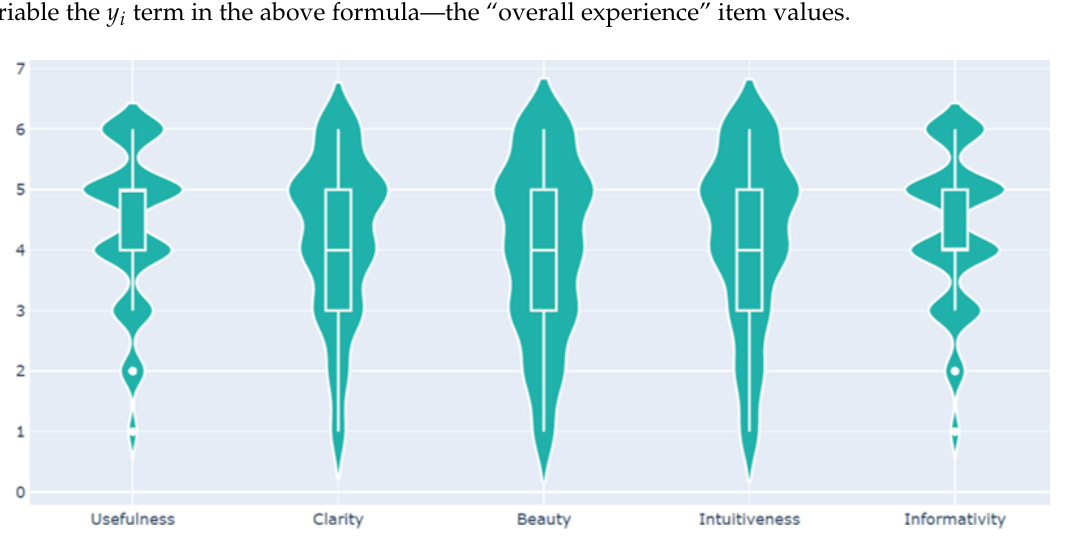
Figure 6. Violin plots of response data. For each value dimension, a box plot shows median, interquartile range, and typical whiskers. Shape around box plots shows probability-density function estimated from respondent sample for each dimension. Dimensions at plot center (Clarity, Beauty, and Intuitiveness) show smoothed distribution with light asymmetry towards higher ratings. Dimensions at two plot sides, namely, Usefulness and Informativity, show more dispersed